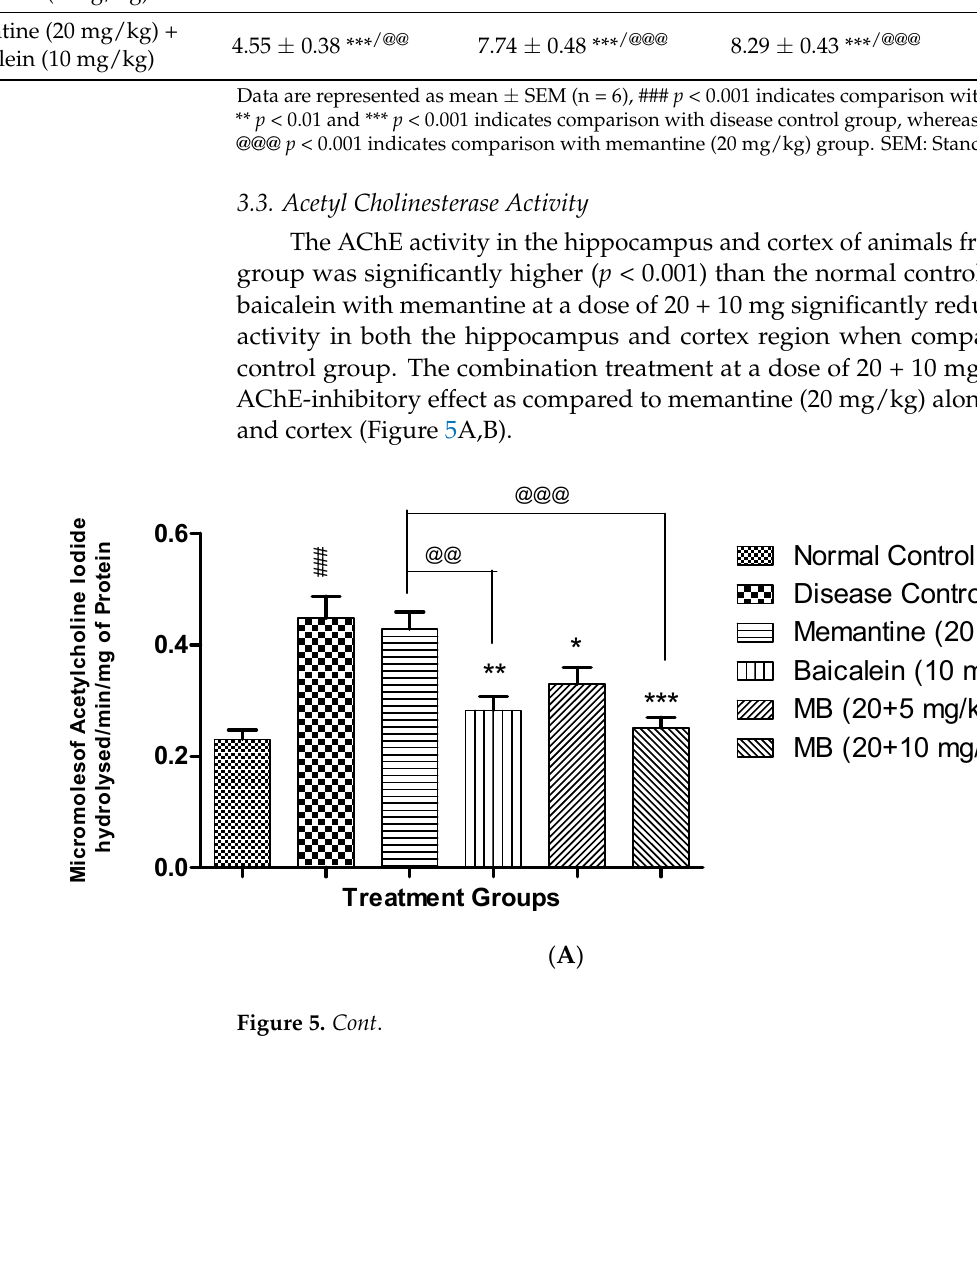
( B ) Figure 5. ( A ). Effect of A β (1–42) , baicalein and baicalein with memantine on AChE in the rat brain hippocampus. Data are represented as mean ± SEM (n = 6), where ### p < 0.001 indicates comparison with normal control, * p < 0.05, ** p < 0.01 and *** p < 0.001 indicates comparison with disease control group, whereas @@ p < 0.01 and @@@ p < 0.001 indicates comparison with memantine (20 mg/kg) group. SEM: Standard Error of Mean. ( B ). Effect of A β (1–42) , baicalein and baicalein with memantine on AChE in the rat brain cortex. 3.4. Histopathological Study 3.4.1. Haematoxylin and Eosin Staining Microscopic examination of the hippocampus and cortex sections from animals from the normal control group did not reveal any signs of pathological significance. However, animals from the disease control group showed multi-focal moderate to marked neuro- degeneration in the hippocampus and cortex. Animals treated with memantine 20 mg/kg showed a focal mild to moderate reduced layer of neuronal cells in the hippocampus, whereas examination of the cortex exhibited multi-focal mild to moderate neuronal de- generation. Treatment of baicalein (10 mg/kg) demonstrated multifocal minimal to mild neurodegeneration in both the hippocampus and cortex. Moreover, combination treat- ment of baicalein with memantine at the dose of 20 + 5 mg/kg also revealed multifocal